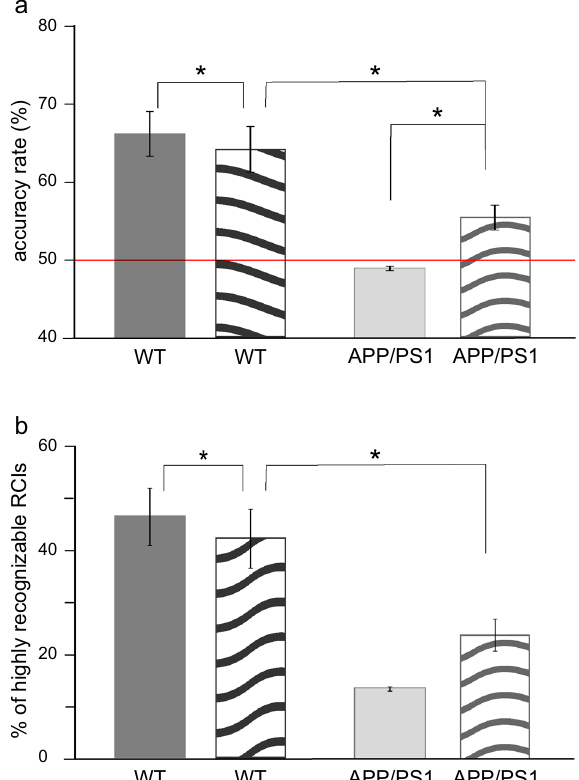
Figure 8. Elimination of the head and tail of RCI has an opposite effect on the CNN’s performance in the WT and APP/PS1 group. ( a , b ) In the WT group reduction of the analyzed signals to SWRs alone resulted in decreasing of the average AR ( p = 0.027, t = 4.1487, t-test with Bonferroni correction) ( a ) and HR RCIs ( p = 0.031, t = 3.9947, t-test with Bonferroni correction) ( b ) compared to the experiment with the full content of RCI exposed to analysis. A reverse effect was expressed in the APP/PS1 group as illustrated by the increase of the mean value of AR ( p = 0.011, t = 5.1624, t-test with Bonferroni correction) (a). Notice however a lack of a significant change of HR RCIs in this group ( p = 0.054, t = 3.4631, t-test with Bonferroni correction). Importantly, the mean value of HR RCIs was still significantly higher in the WT compared to APP/PS1 animals ( p = 0.049, t = 2.869, t-test with Bonferroni correction) Dark bars represent average values of AR and HR RCIs in the experiment with the full content of RCIs, patterned bars correspond to the experiment with the elimination of the head and tail of RCIs. Other abbreviations as in Fig.